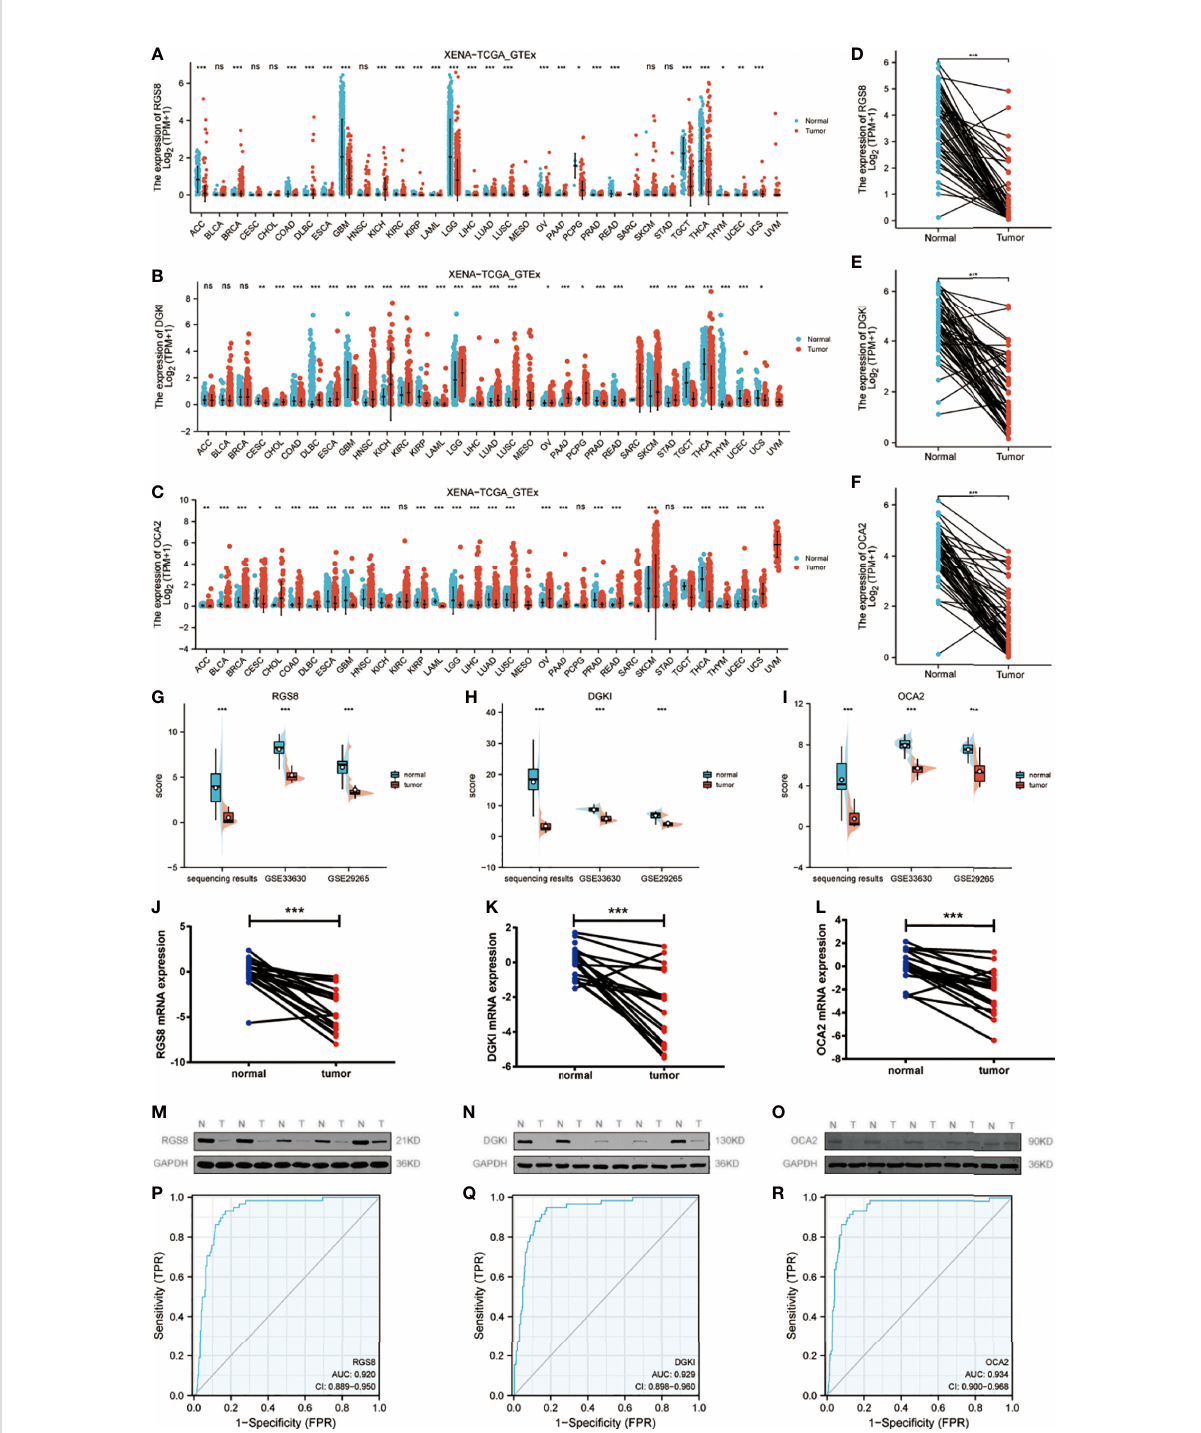
FIGURE 2 Expression of RGS8, DGKI and OCA2 was decreased in THCA tissues. In different cancers in TCGA and GTEx databases, the upregulation and downregulation levels of RGS8 (A) , DGKI (B) , OCA2 (C) . The expression levels of RGS8 (D) , DGKI (E) , OCA2 (F) in THCA, n=58. The expression levels of RGS8 (G) , DGKI (H) , OCA2 (I) in transcriptome sequencing results, GSE33630 and GSE29265. The expression levels of RGS8 (J) , DGKI (K) , OCA2 (L) in 20 pairs of papillary thyroid carcinoma tissues and adjacent normal tissues were detected by qRT – PCR. The expression levels of RGS8 (M) , DGKI (N) , OCA2 (O) in 5 pairs of papillary thyroid carcinoma tissues and adjacent normal tissues were detected by western blotting. The ROC curve of RGS8 (P) , DGKI (Q) , OCA2 (R) . *p < 0.05, **p < 0.01, ***p < 0.001, NS, no signi fi